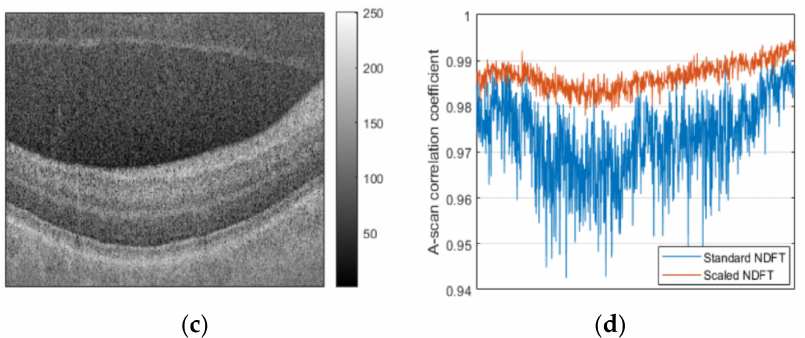
Figure 2. ( a ) Original OCT image of a human retina; ( b ) reconstructed image using standard NDFT (without scaling); ( c ) reconstructed image using our scaled NDFT; ( d ) correlation coefficients between corresponding A-scans of the original image and each reconstructed image.